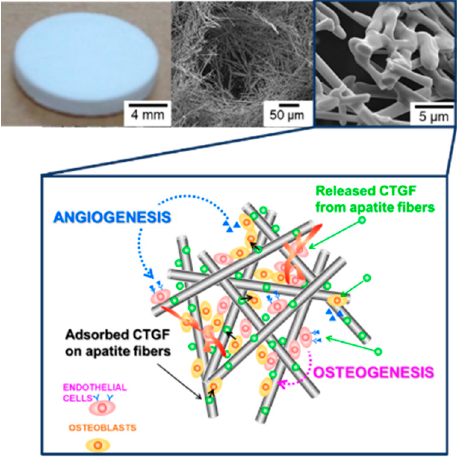
Figure 9. Schematic diagram of CTGF-loaded AFS. Schematic diagram of the relation between osteogenesis and angiogenesis by CTGF stimulation. Both released and adsorbed CTGF might stimulate osteoblasts and endothelial cells.